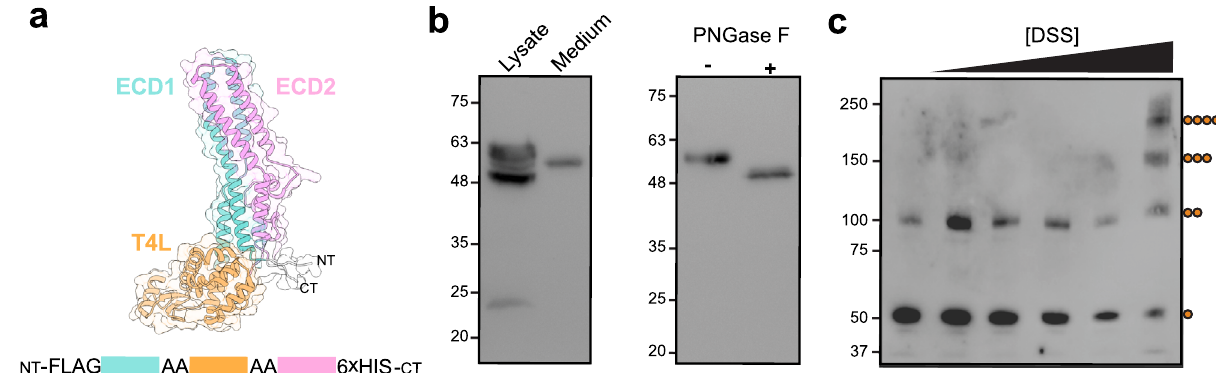
Fig. 6 mTTYH3 ECDs form tetramers in solution. a A model of ECD1-T4L-ECD2 was generated using AlphaFold 2 31 . b Western blot analyses of mTTYH3 ECD1-T4L-ECD2 expression using anti-FLAG. Note the single band observed in the secreted fraction (Medium), compared with the multiple intracellular forms (Lysate) (left panel), and the effect PNGase F treatment (500 units) (right panel). c Cross-linking using increasing concentrations of DSS (concentrations used were 0, 10, 50, 100, 200, and 2000 μ M from left to right) resulted in the exposure of higher oligomeric assemblies, culminating in a mass corresponding to that expected for a